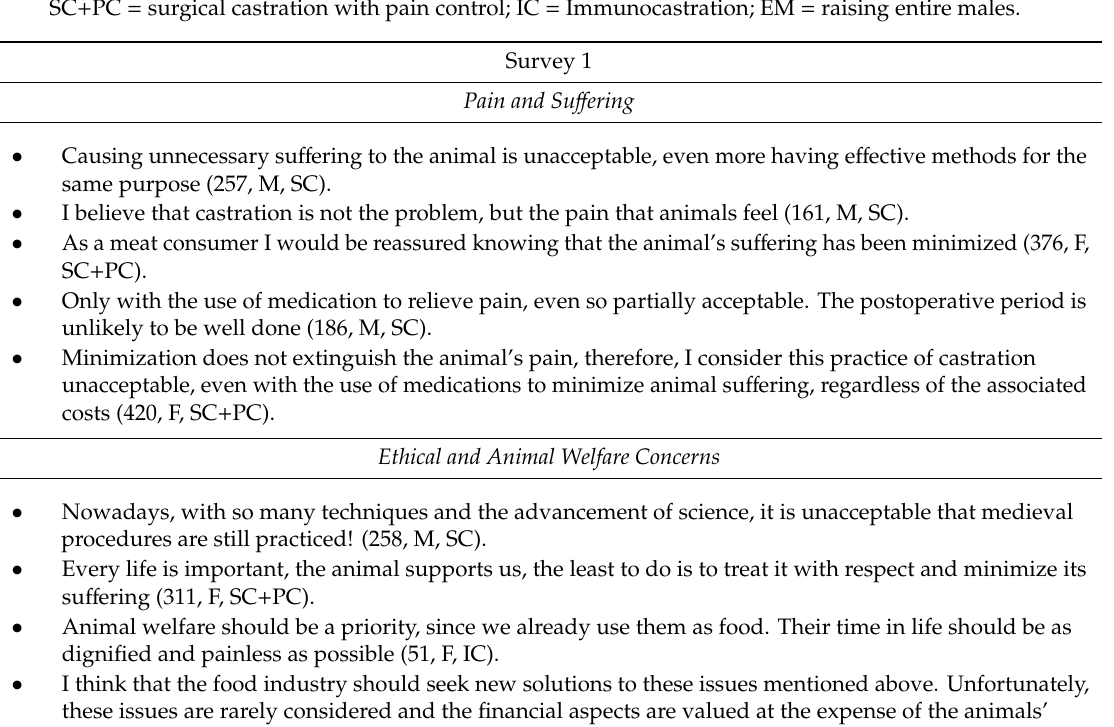
Table A2. Selected quotes extracted from the open-ended question, justifying attitudes towards di ff erent methods to deal with boar taint in pigs (Sv1, n = 441 southern Brazilian citizens; Sv2, n = 768 Brazilian citizens). Quotes are followed by participant number, gender (F = female, M = male), and participant’s treatment (the method to deal with boar taint in pigs). SC = surgical castration without pain control; SC + PC = surgical castration with pain control; IC = Immunocastration; EM = raising entire